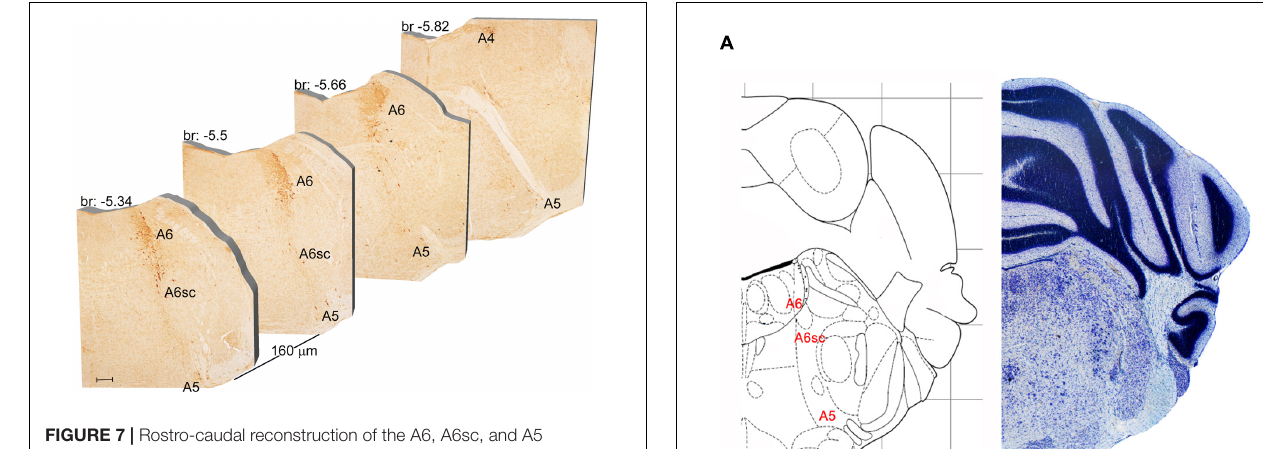
cerebellum, extending caudally and medially to the NTS. Here the floor of the fourth ventricle is barely detectable; it is caudally defined by the obex, while rostrally continues toward the ala cinerea, where the C2/A2 cell groups are routinely defined ( Figures 9 , 10A,B